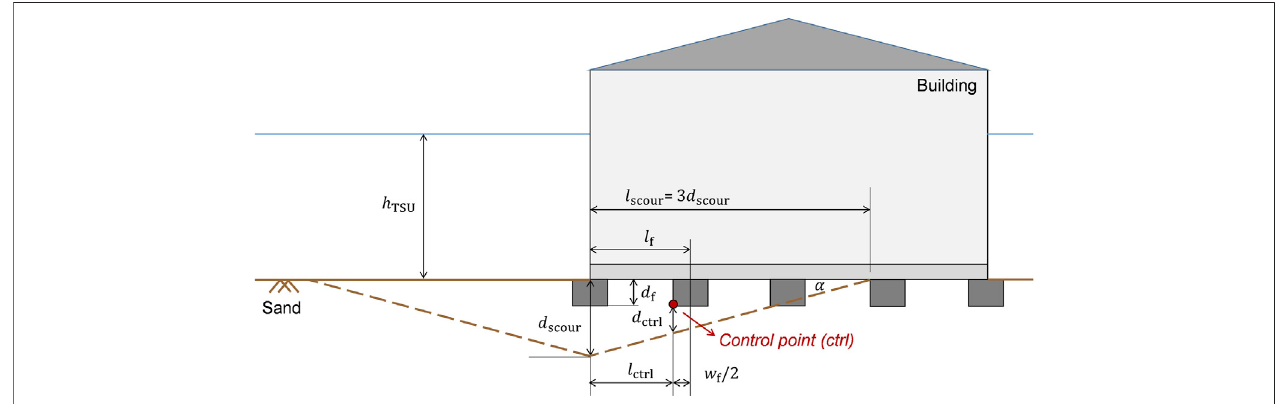
FIGURE 2 | Example sketch illustrating the effects around building with shallow foundations on noncohesive soils and the calculations for the second footing from the left corner.